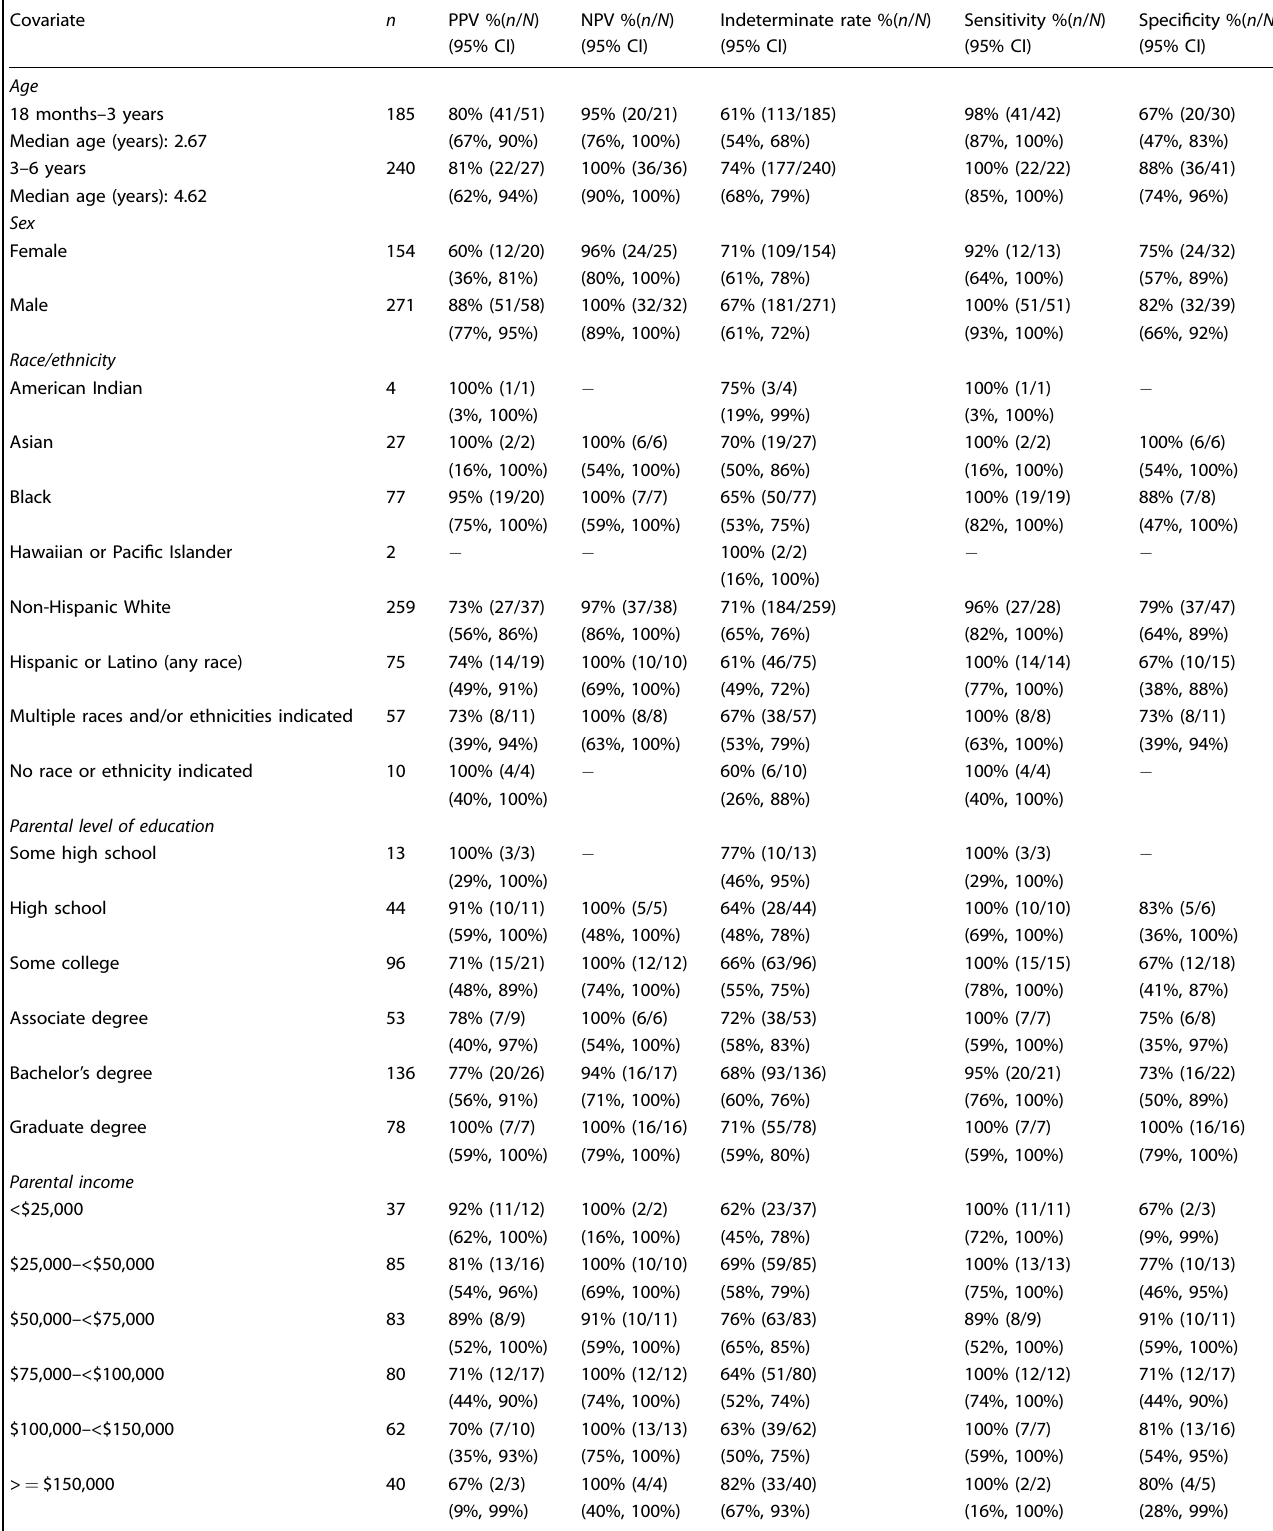
Table 4. Device performance metrics by